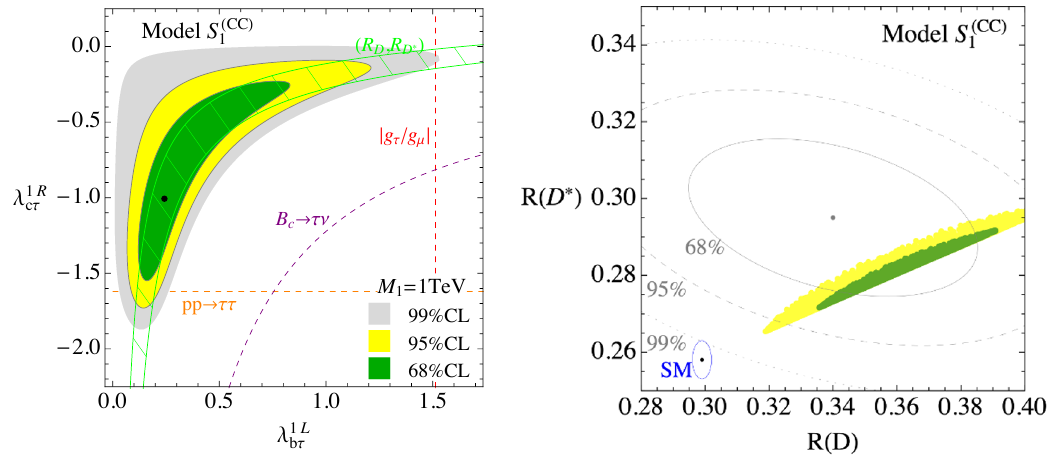
Figure 1 . Result from a fit in the two S 1 couplings λ 1 L the left panel we show the preferred regions in the plane of the two couplings, and the individual 2 σ limits from the most relevant observables (except for ( R ( D ) , R ( D ∗ )) , for which we show the 68% CL region). The black dot corresponds to the best-fit point. In the right panel we show where this preferred region is mapped in the plane of R ( D ) − R ( D ∗ ) , together with the experimental combination from HFLAV